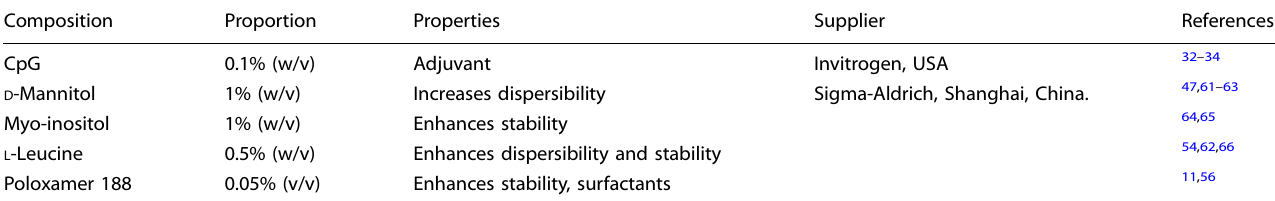
Table 1. Composition and proportion of AHc spray-drying